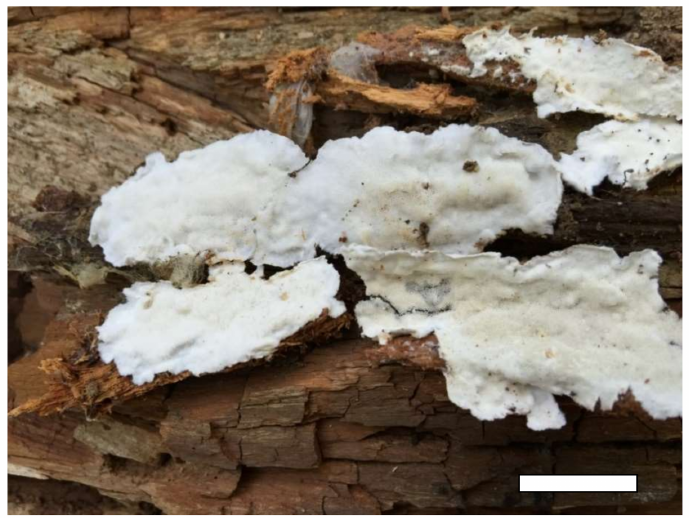
Figure 4. A basidioma of Sidera inflata (from the holotype Cui 13610). Scale bar = 10